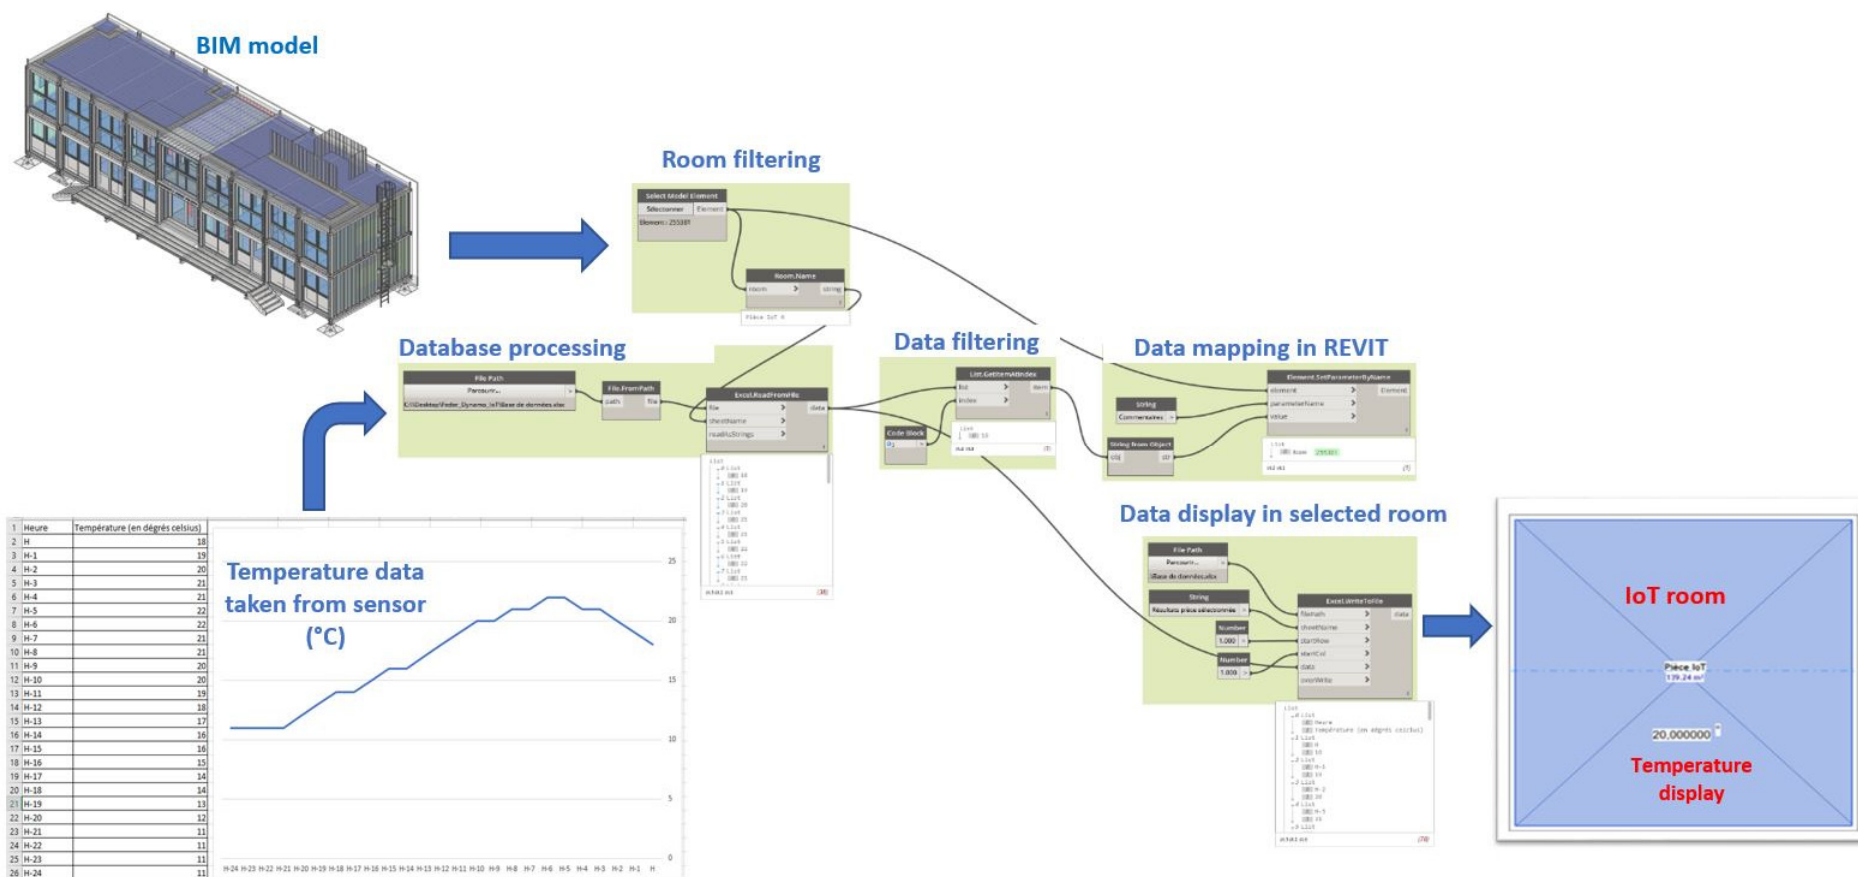
Figure 9. Dynamo program showing the state of a room in a BIM model and visualising the changes in temperature values.